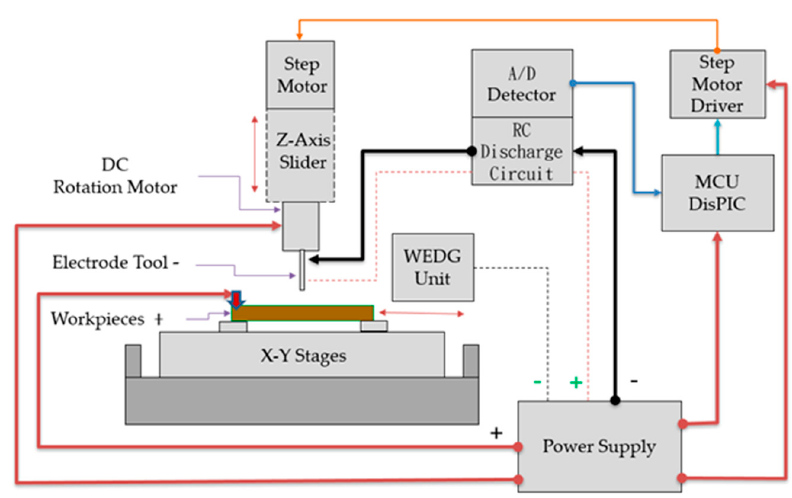
Figure 1. The block diagram sketch of the desktop micro-electrical discharge machining (micro-EDM) system.